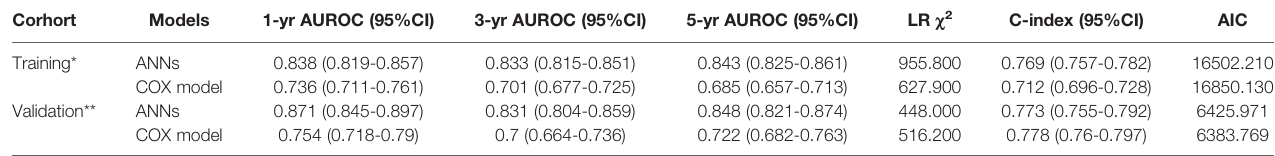
TABLE 3 | Comparison of the performance and discriminative ability between ANNs and COX model.